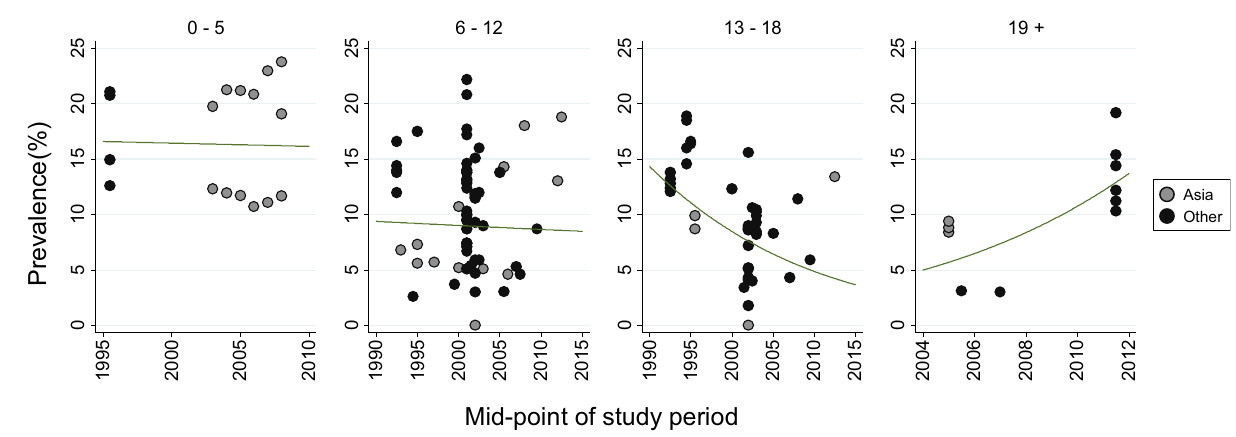
Figure 4. 12-month prevalence of AD by age groups (0–5, 6–12, 13–18 and 19 + years) and region over